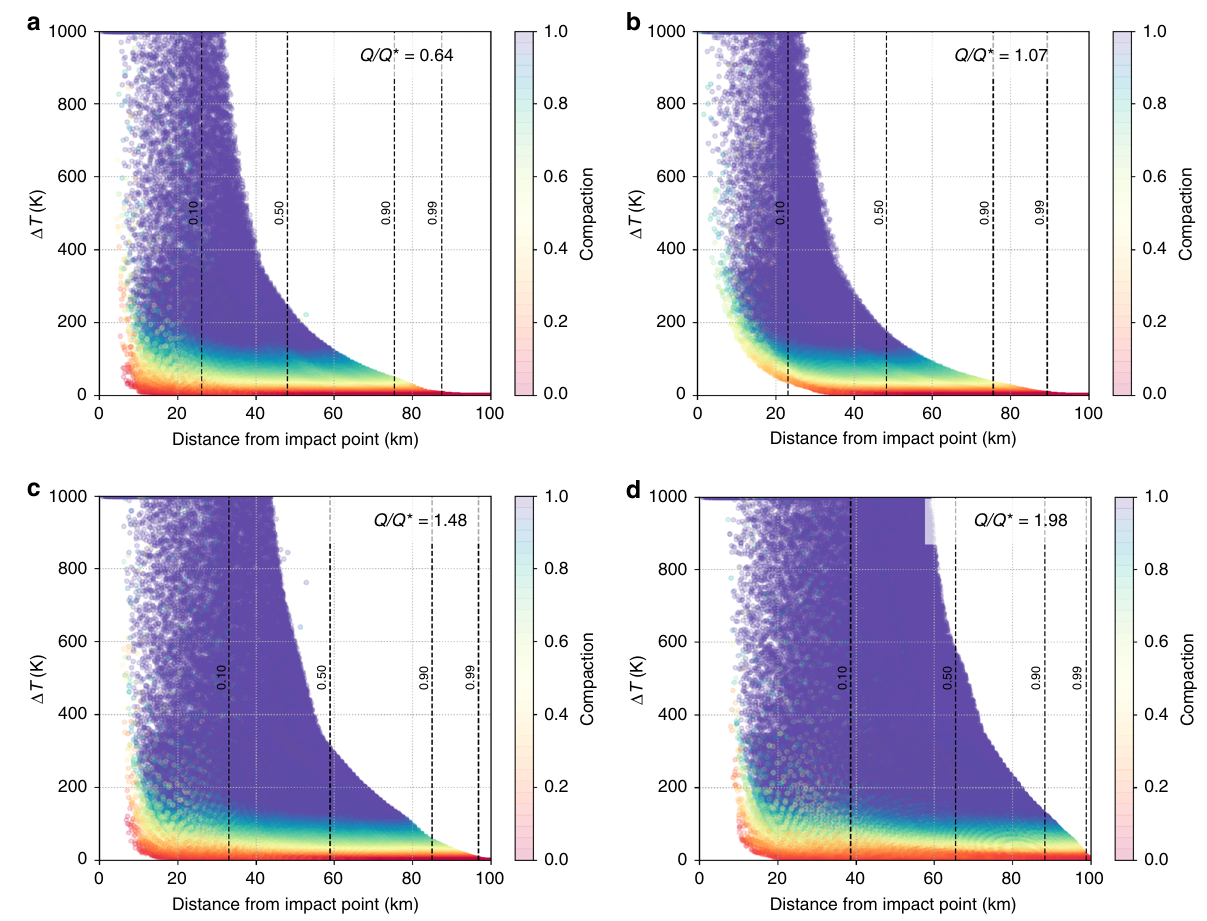
Fig. 5 Super-catastrophic disruptions produce a large diversity of thermally altered rubble-piles. From a to d , the impact energy Q is increased from below the impact energy threshold for disruption Q* ( a ) to above Q* ( b – d ). For each simulation, we show the peak temperature change of each particle ( y- axis), its distance from the impact point ( x- axis), and its postimpact compaction (color scale). Particles closer to the impact point are more heated and compacted, and particles that experience a change in temperature of ≳ 200 K are almost fully compacted. The vertical black dashed lines highlight different fractions of escaping material that originates from within a given distance of the impact point. For increasingly higher impact energies, escaping material originates at further distances from the impact point (for example, c shows an impact where Q / Q* = 1.481, which results in 50% of the escaping material originating from >60 km away from the impact point). Three-dimensional visualizations of the peak temperature changes and compaction of material in the parent body are presented in Supplementary Figs. 3 and